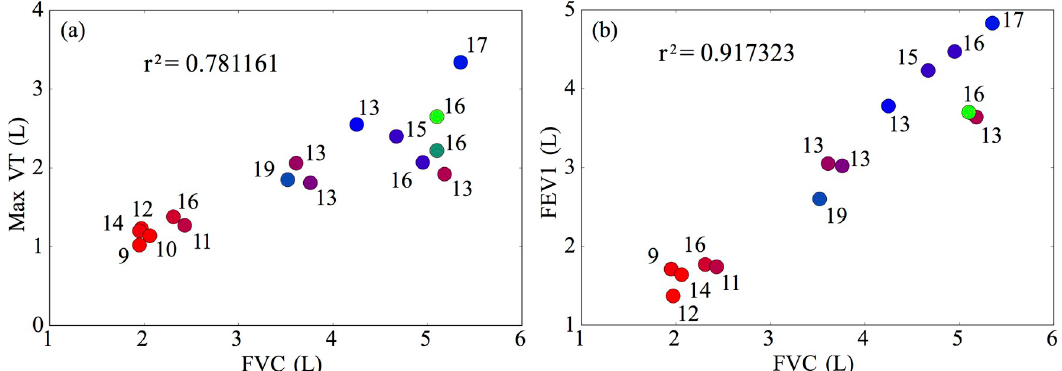
Fig 4. (a) Correlation of FEV 1 with the maximal tidal volume achieved throughout the test. (b) Correlation between FEV 1 and FVC is high. Note that, although FVC and FEV 1 are good predictors of poor test performance, they are unable to distinguish better performing participants.